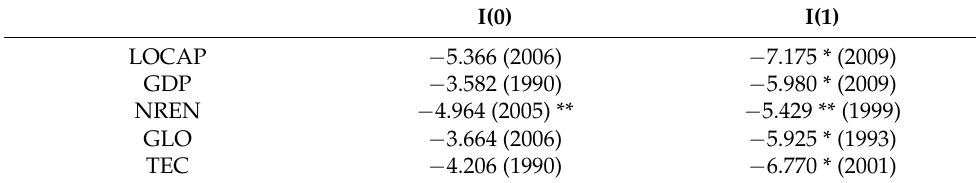
Table 4. Structural break unit-roots outcome.